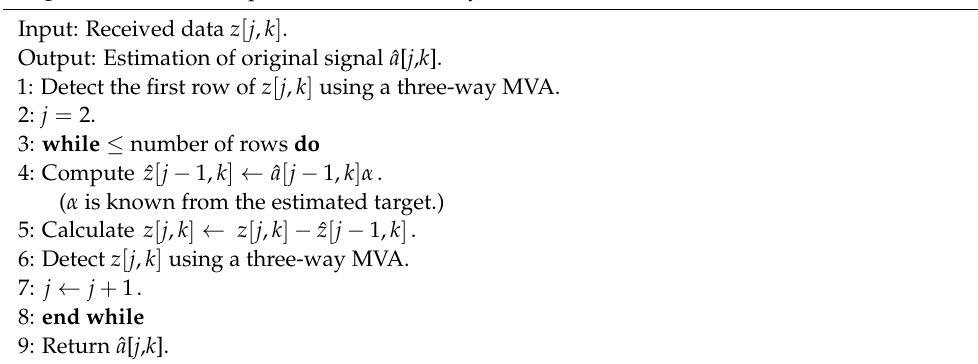
Algorithm 1 Detection procedure of three-way MVA with